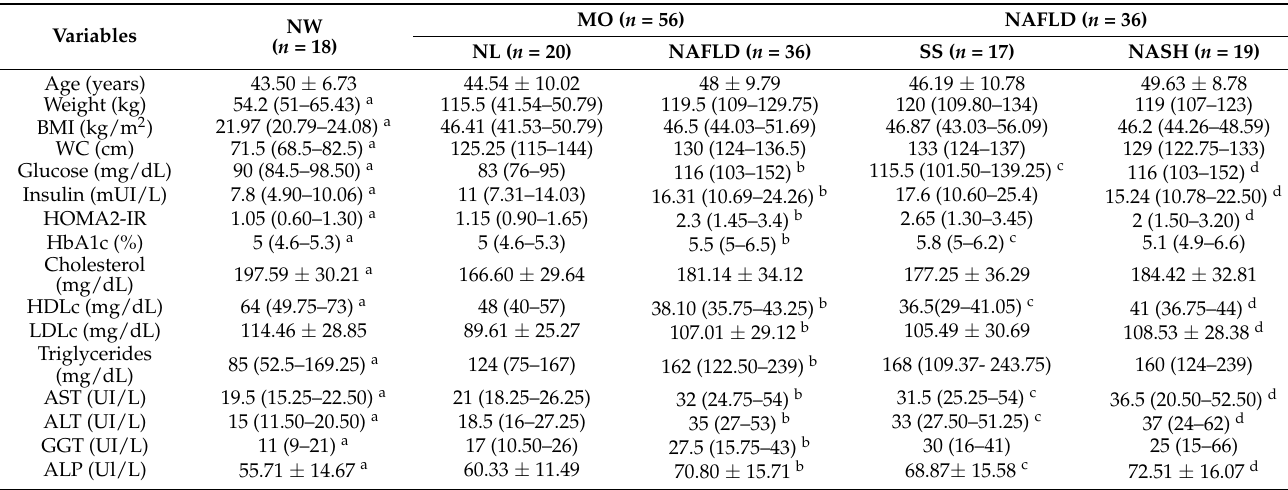
Table 1. Anthropometric and biochemical variables of the study classified according to the BMI and the hepatic histopatho- logical